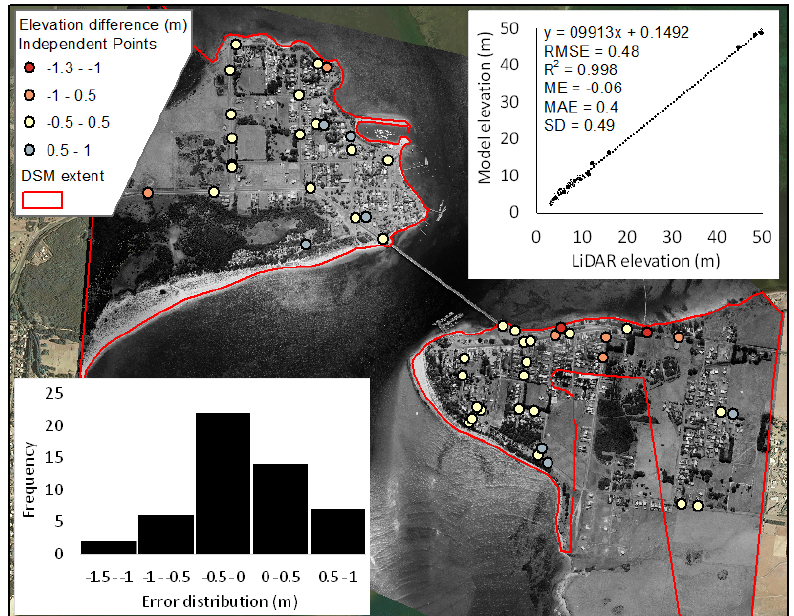
Figure 3. The 1977 DSM extent and orthomosaic. Coloured points show the elevation difference (m) for each of the 51 points used in the accuracy assessment between the 2007 LiDAR data and the 1977 DSM. Negative values (cold colours) indicate elevations higher than LiDAR, while positive values (hot colours) denote elevations lower than LiDAR. The frequency distribution of errors and model evaluation parameters are included as insets.